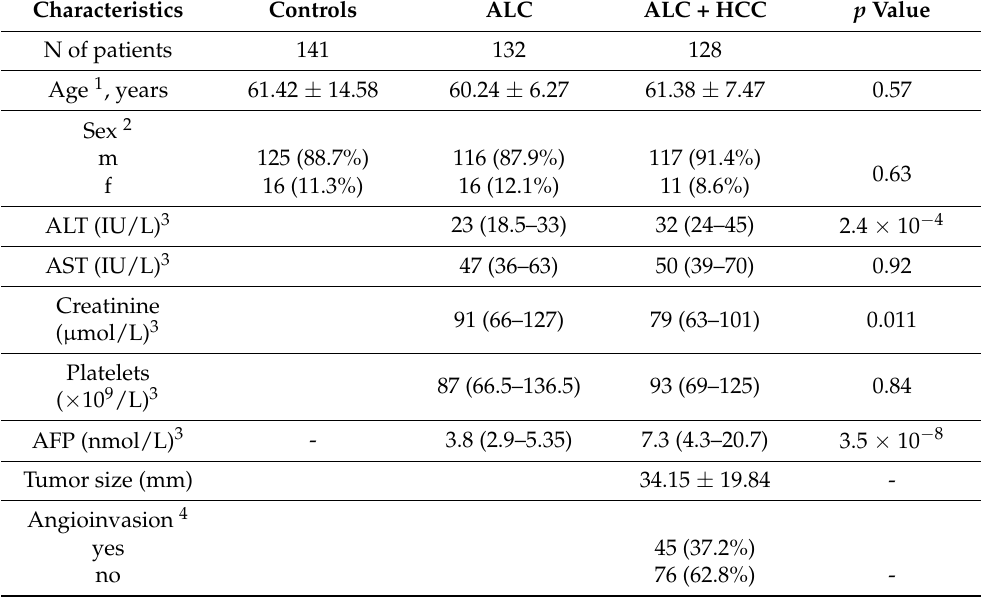
Table 1. Demographic, laboratory and histopathology information on different study